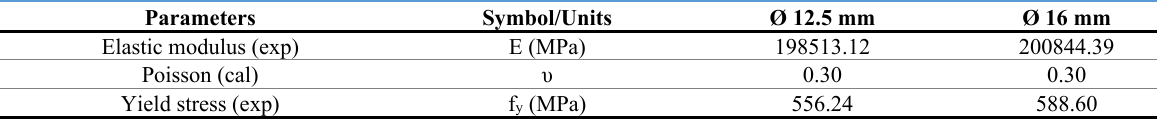
Table 9. Mechanical properties used for the Von Mises model (reinforcement). Parameters